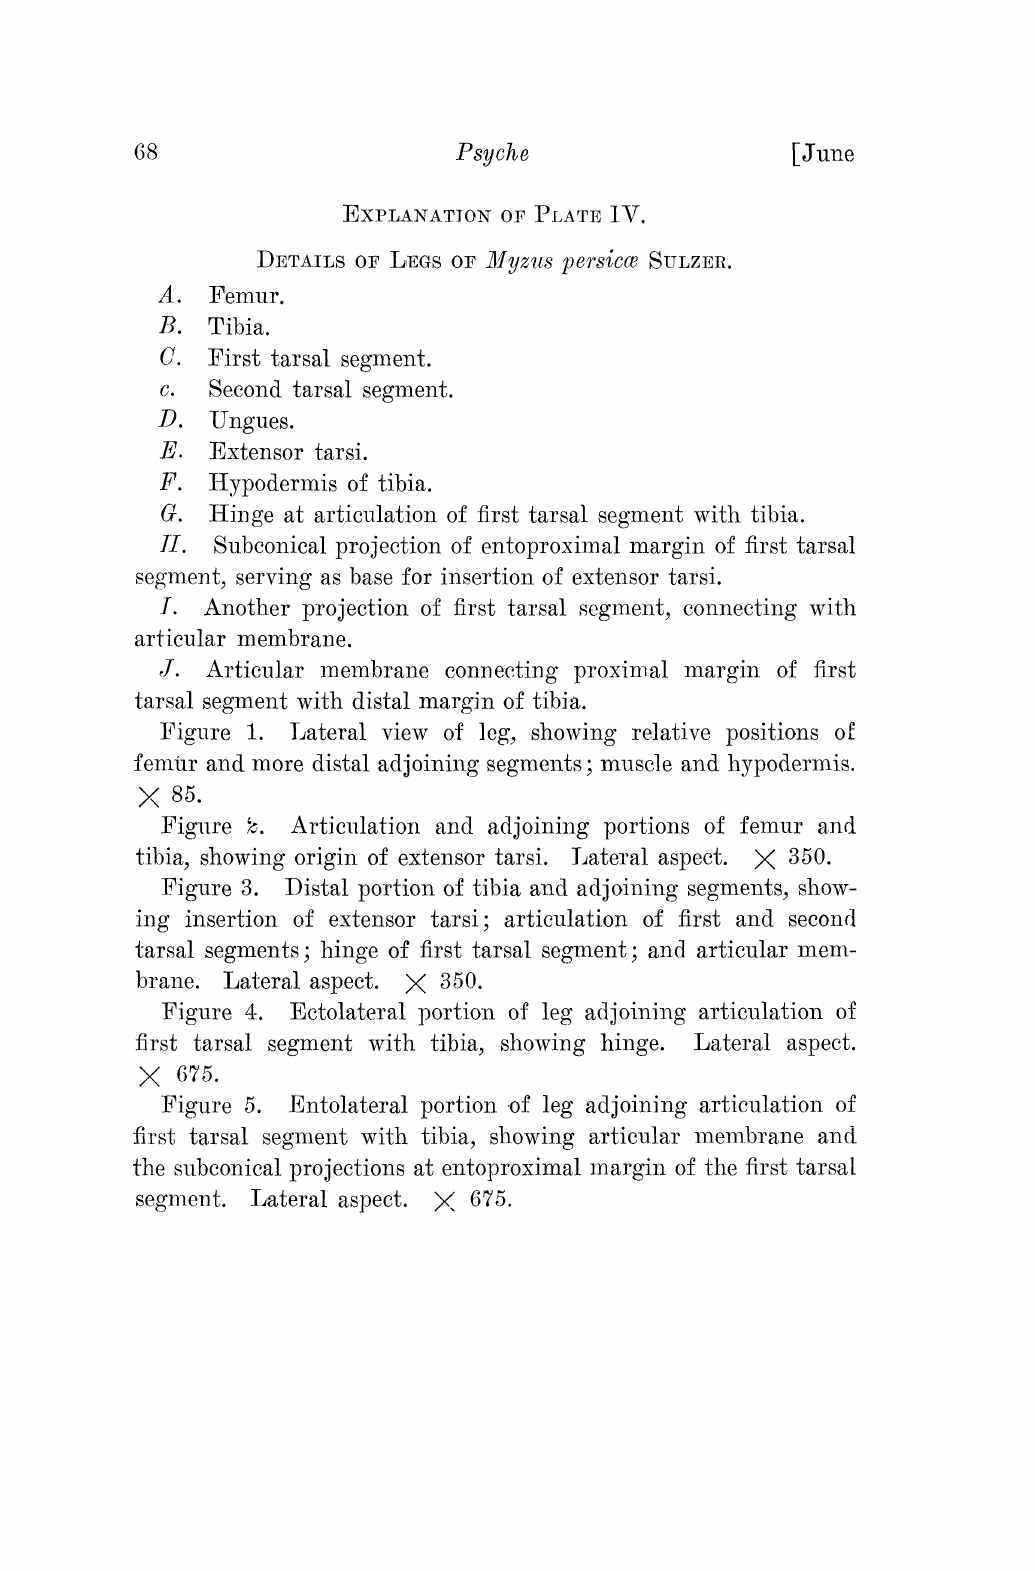
Figure 1. Lateral view of leg, showing relative positions .. femur and more distal adjoining segments; muscle and hypodermis. X 85. Articulation and adjoining portions of femur and Figure tibia, showing origin of extensor tarsi. Lateral aspect. X 350. Figure 3. Distal portion of tibia and adjoining segments, show- ing insertion of extensor tarsi; articulation of first and second tarsal segments; hinge of first tarsal segment and articular mem- brane. Lateral aspect. X 350. Figure 4. Eetolateral portion of leg adjoining articulation of first tarsal segment with tibia, showing hinge. Lateral aspect. X Figure 5. Entolateral portion .of leg adjoining articulation of first tarsal segment with tibia, showing articular membrane and the subconical projections at entoproximal margin of the first tarsal